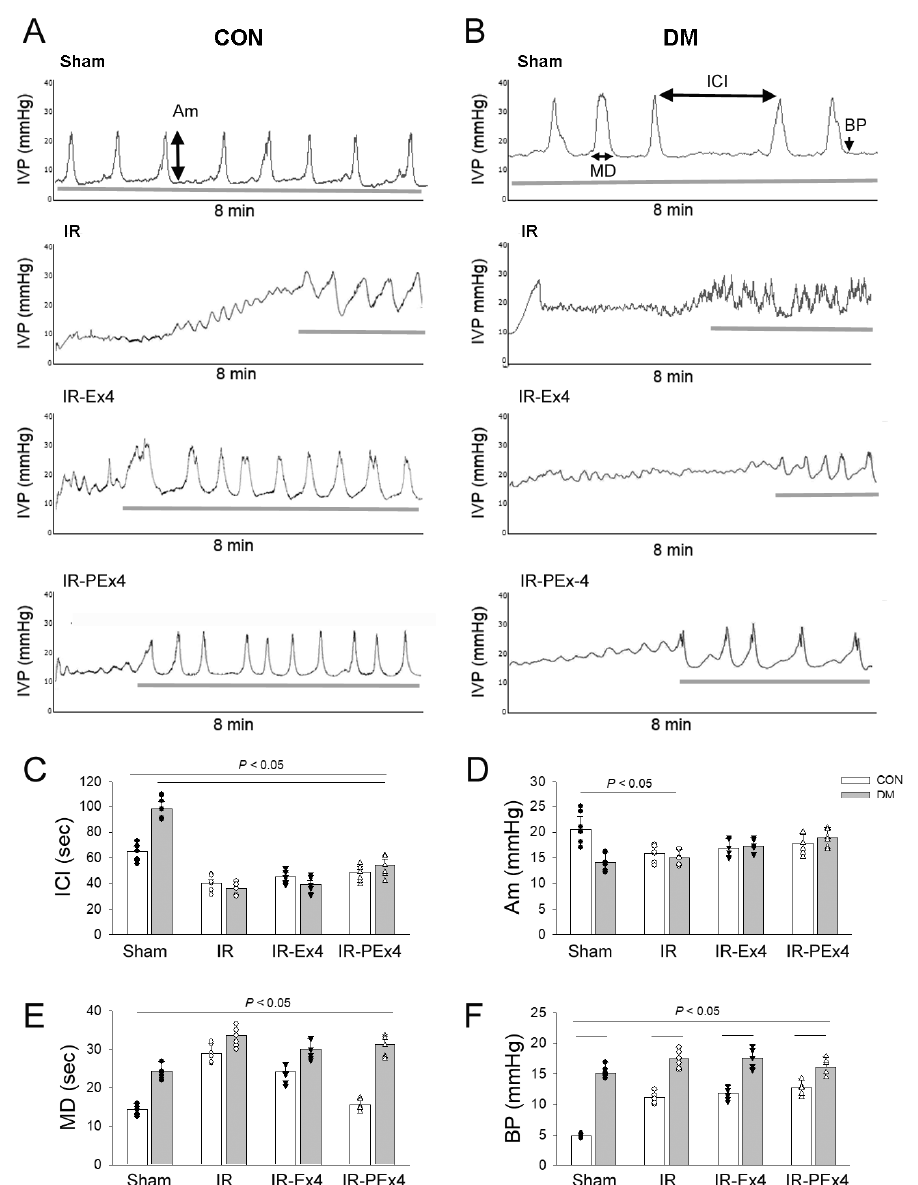
Figure 7. Effect of Ex-4 and PEx-4 on the voiding function in response to stroke injury (IR) among the eight groups of rats. Representative traces of continuous cystometrograms in urethane-anesthetized rats of Control ( A ) or DM groups ( B ). The normal voiding pattern and parameter are demonstrated in Control (Con), whereas a hyposensitive underactive bladder with an increased ICI is indicated in DM bladders. IR caused urine incontinence, depressed ICI, Am, increased MD and BP in Con and DM bladders. The treatment of Ex-4 (IR-Ex4) or PEx-4 (IR-PEx4) seems to play a role in improving IR or DMIR-induced voiding dysfunction. Data are expressed as mean ± SEM in each group ( n = 6) using the single values. ( C ): ICI, intercontraction interval; ( D ): Am, amplitude; ( E ): MD, micturition duration; ( F ): BP, baseline bladder pressure. The statistical difference is indicated by the horizontal line with p < 0.05 between groups using one-way ANOVA, followed by Bonferroni’s post hoc test. Each symbol represents one sample in different